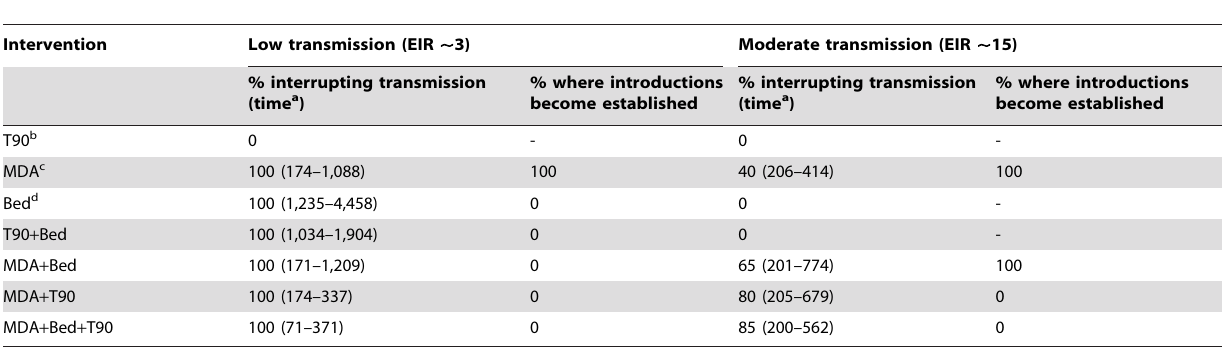
Table 2. Ability of simulated interventions to interrupt malaria transmission and control reintroductions.